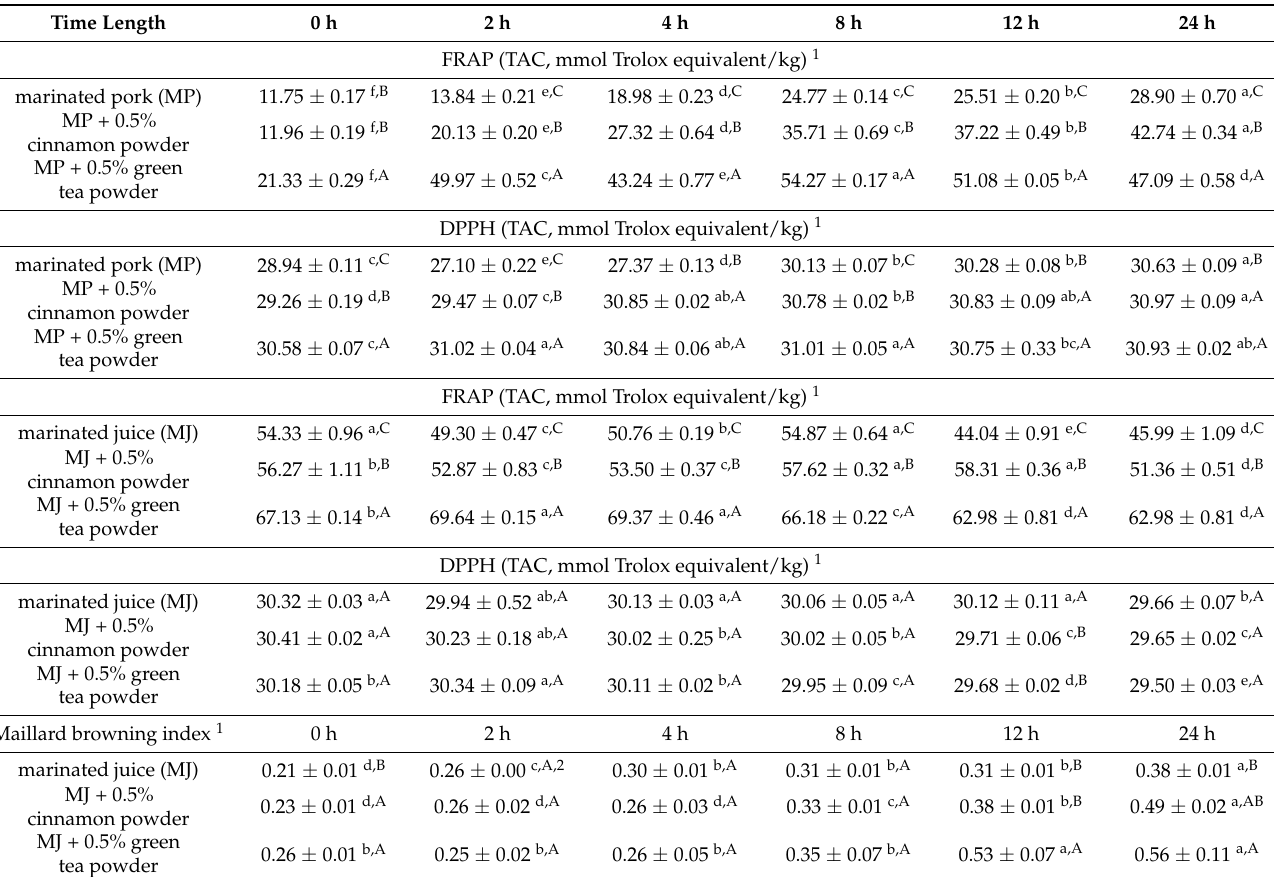
Table 4. Antioxidant capacity as well as Maillard browning index of marinated pork and juice as affected by different flavorings and time